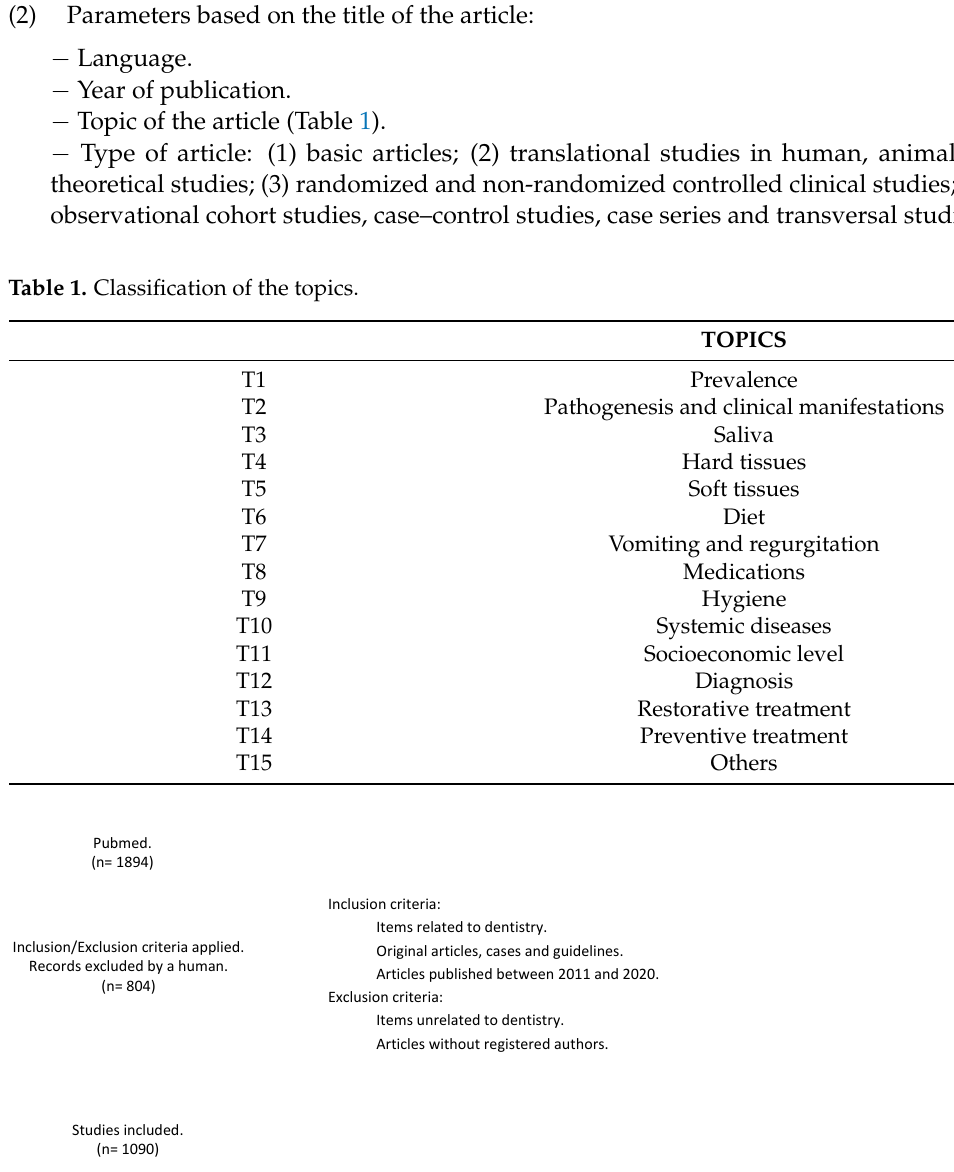
Figure 2. PRISMA flow diagram of article search and selection process. The literature search was conducted in April 2021.